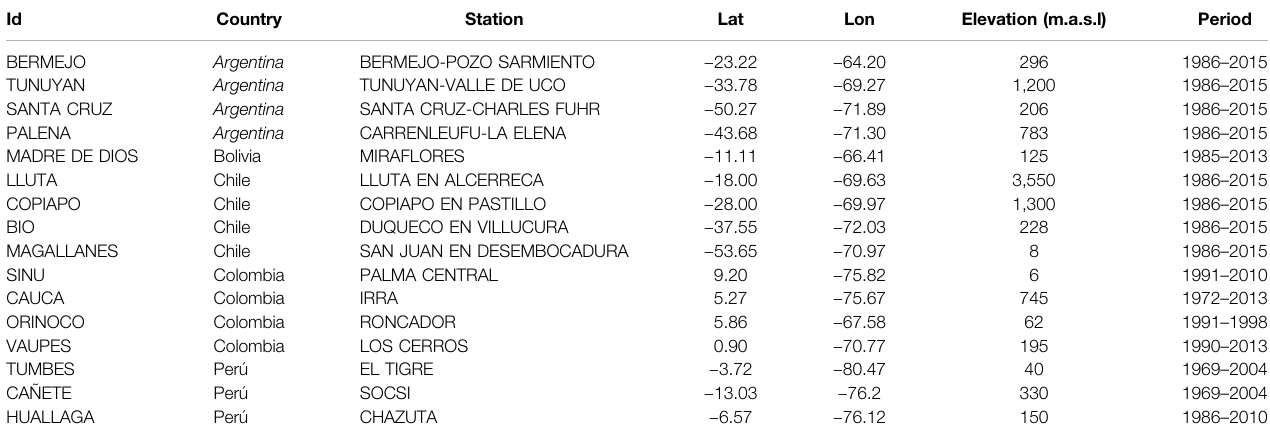
TABLE 1 | General information of the selected runoff gauges corresponding to the mean annual cycles shown in Figure 1B